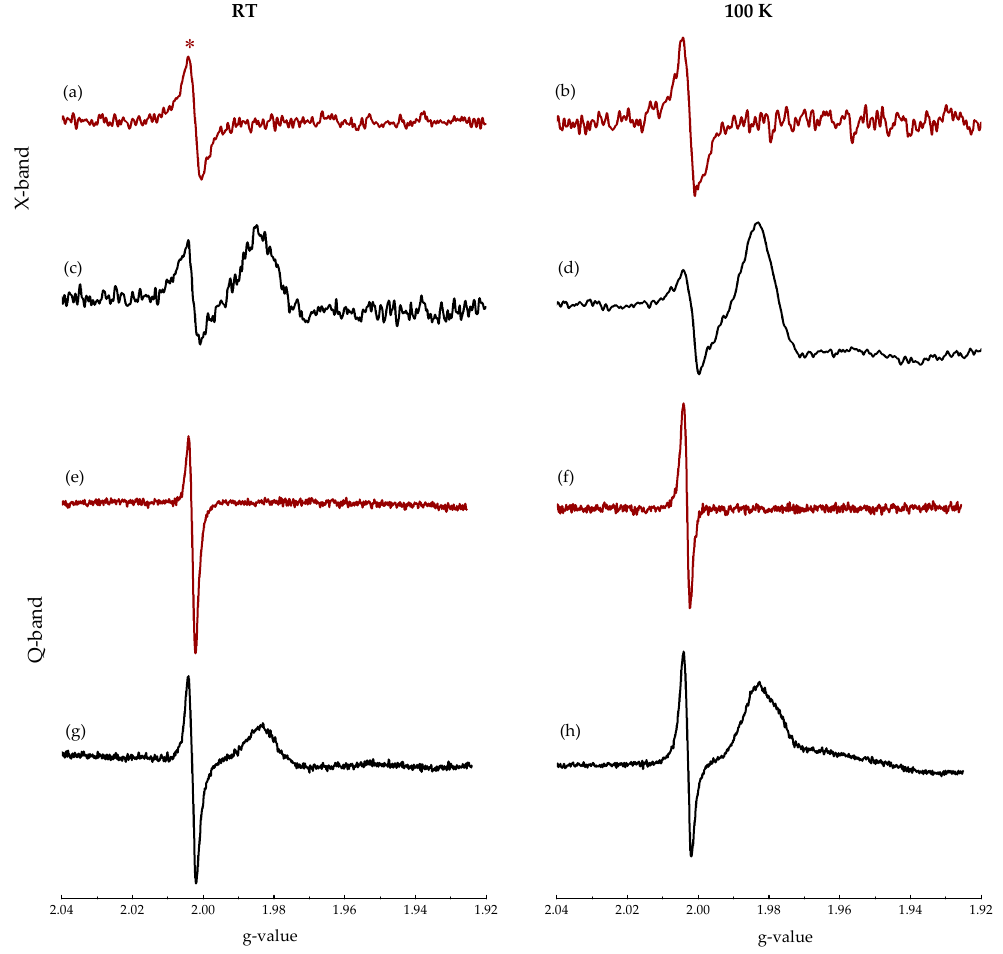
Figure 1. X ‐ band and Q ‐ band EPR spectra of ( a , b , e , f ) pristine g ‐ C 3 N 4 powder and ( c , d , g , h ) M1 powder measured in the dark at room temperature (RT) and 100 K. *: Signal at g = 2.003 attributed to the conduction electrons in the localized π‐ states of g ‐ C 3 N 4 .